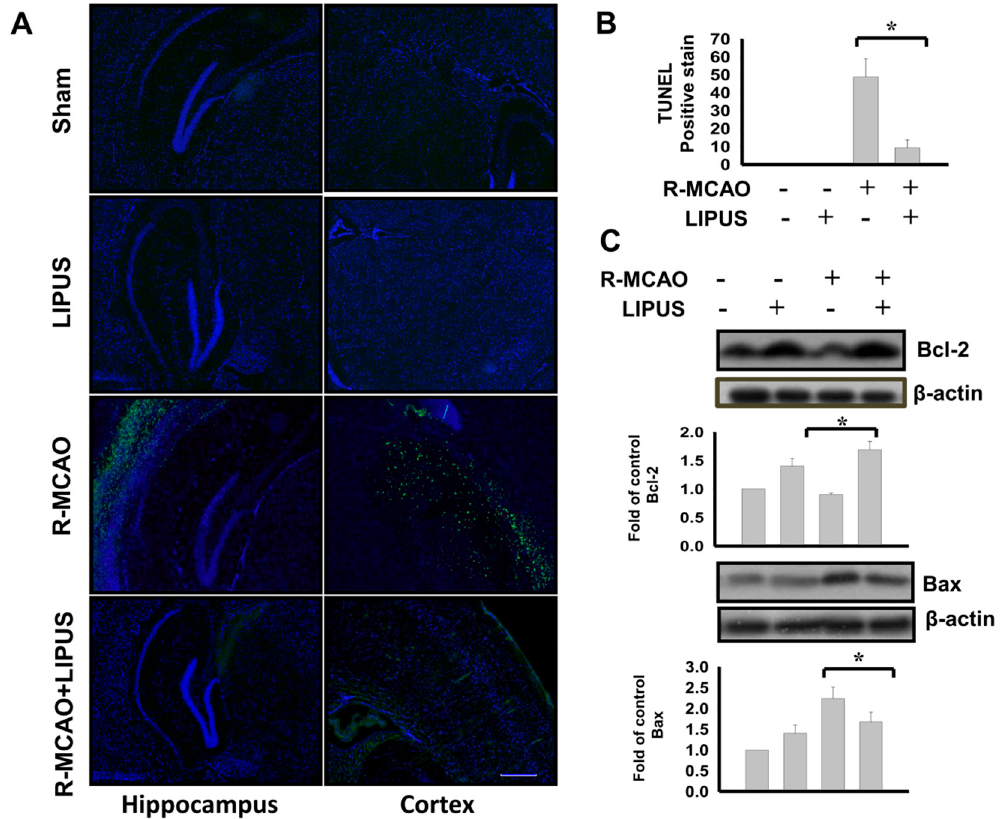
Figure 3. LIPUS treatment reduced the neuronal cell apoptosis in the left cerebral hemisphere tissues of the recurrent stroke mice. Mice were treated with LIPUS 15 min daily for nine consecutive days before the secondary MCAO procedure. The detection of neuronal apoptotic cells was performed by the TUNEL staining in the hippocampus and cortex. TUNEL-positive cells were presented as the fluorescent green color, while cell nuclei were displayed as the fluorescent blue color (scale bar = 200 µ m) ( A ). The TUNEL-positive cells were counted and shown in ( B ). The protein expressions of Bax and Bcl-2 were determined by Western blotting in brain tissues ( C ). Data are presented as mean ± S.D. ( n = 6 per group). The ANOVA followed by the Bonferroni’s test was used for statistical analysis. * p < 0.05, versus R-MCAO group. L: LIPUS alone, R-MCAO: recurrent stroke model.